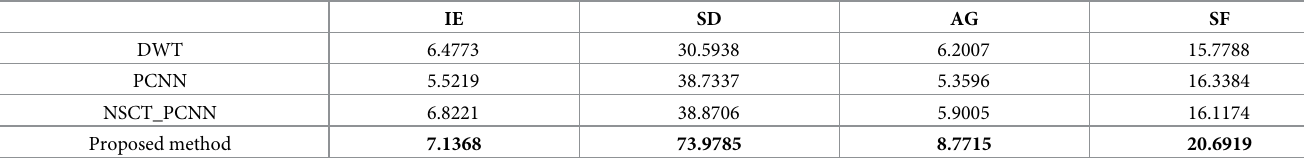
Table 3. Objective evaluation of the third group of